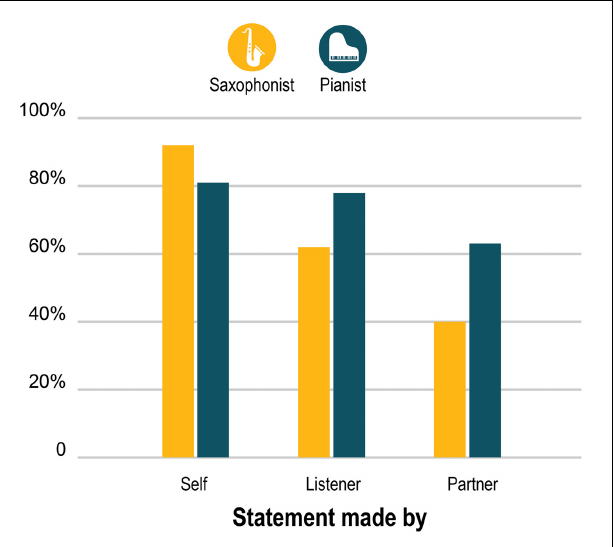
FIGURE 3 | Percent of the 151 statements originally made by themselves, the outside listener, and their partner that the pianist and saxophonist endorsed (by selecting 4 or 5 on the 5-point